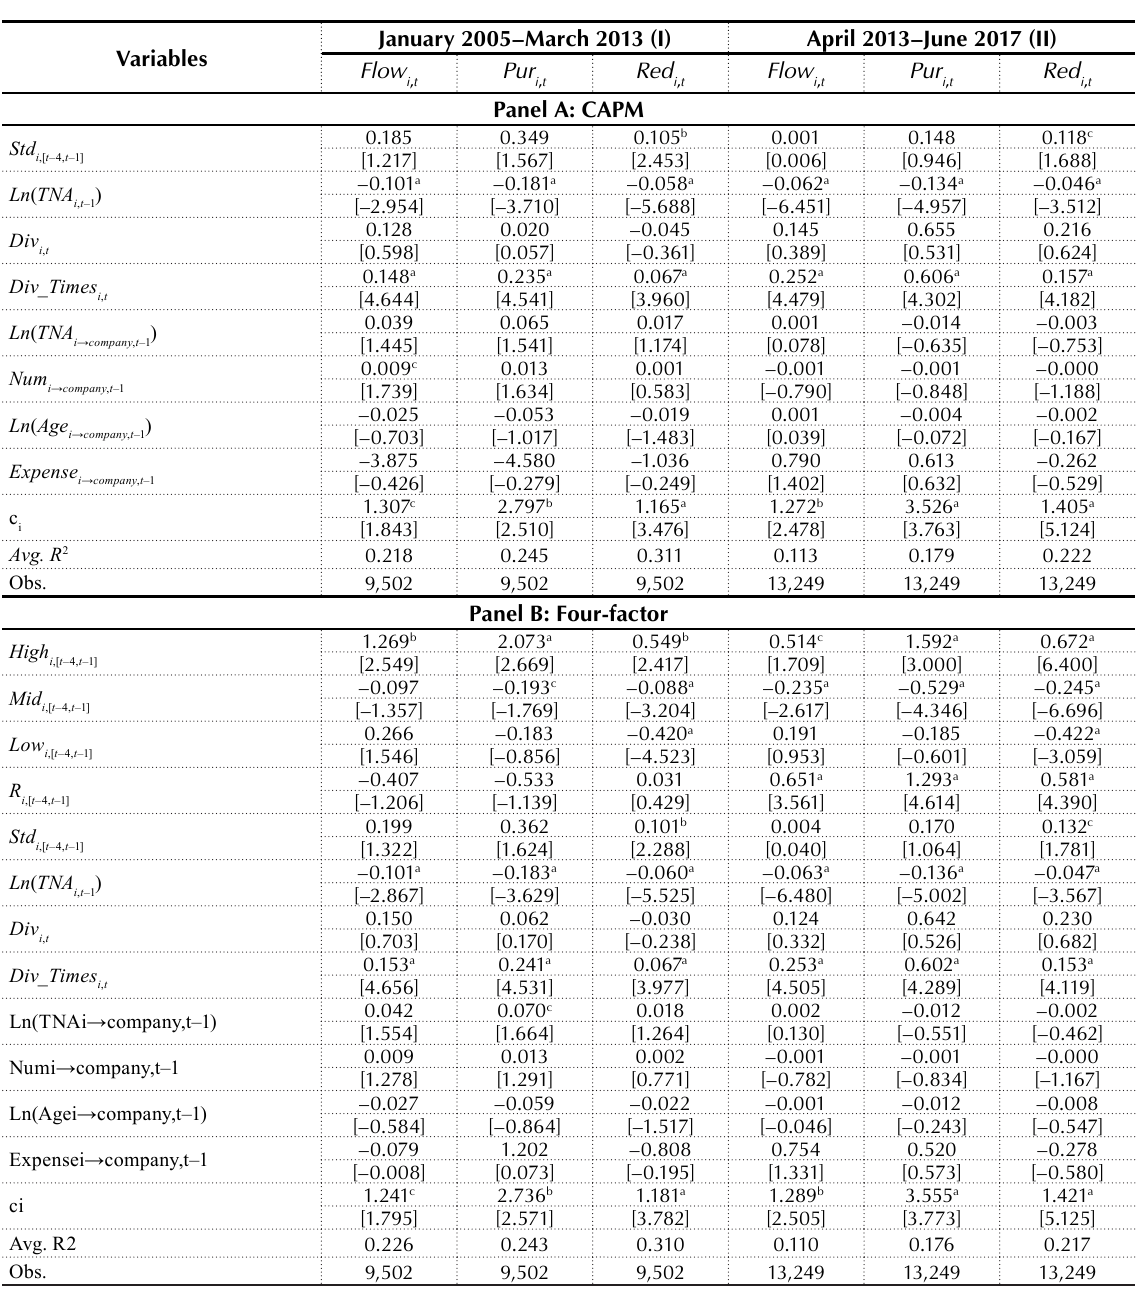
Table 6 (cont.). Robustness test on two subperiods: CAPM alpha and four-factor